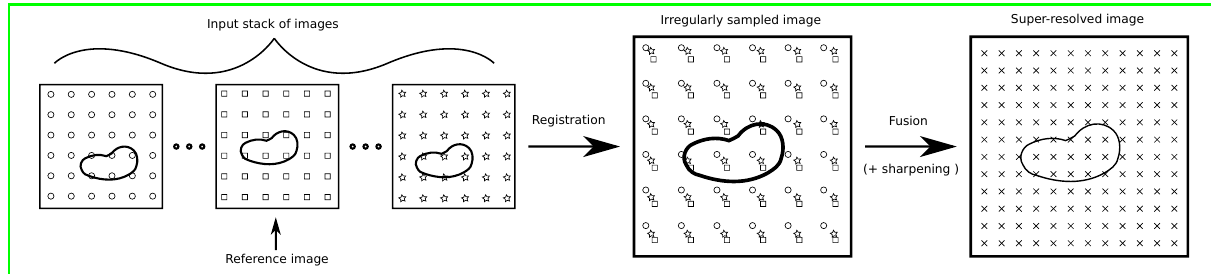
Figure 2. Pipeline of the super-resolution method. Each input image is registered onto a reference image to create an irregularly sampled signal. The uniformly sampled image at the requested resolution is then produced by combining the